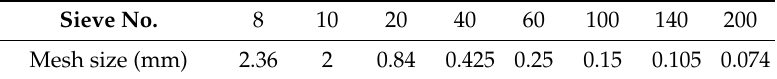
Table 3. The sieve numbers and mesh sizes.